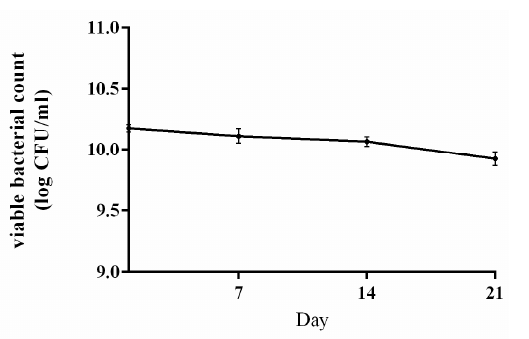
Figure 3. Change in viable count of fermented milk made with Lpb. plantarum NMGL2 during 21 days of storage at 4 °C